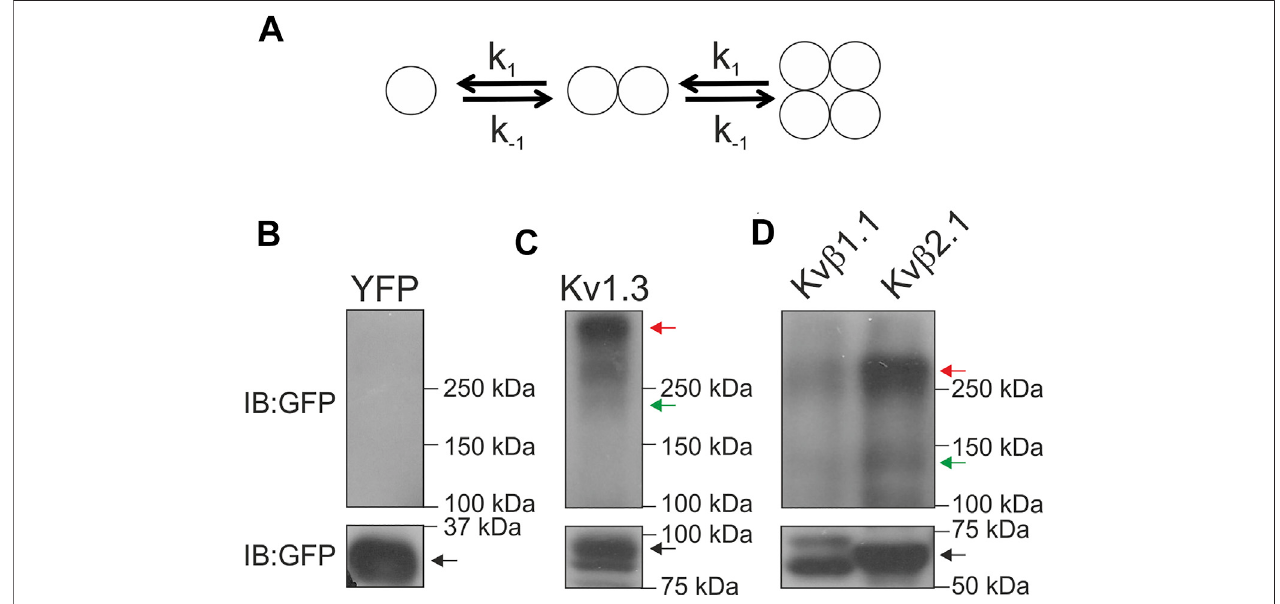
FIGURE5| Kv β 1.1andKv β 2.1formdimericand tetrameric structures. (A) Modelrepresentingthetwoputative optionsforKv β oligomerization.Kv β formsdimers, andKv β formstetramericstructuresbyassociation.Theaf fi nityconstant(k)foreverystepwouldbethesameinallconditions. (B – D) HEK293cellsweretransfectedwith YFP, Kv1.3YFP, Kv β 1.1YFP and Kv β 2.1YFP. Total lysates were analyzed in semidenaturating conditions. (B) YFP, (C) Kv1.3YFP, (D) Kv β 1.1YFP and Kv β 2.1YFP. Immunoblots (IB) were performed with an anti-GFP antibody. Blots were split into two for low- and high-molecular-weight forms for better visualization. The black arrow indicates monomeric forms. The green arrow indicates dimeric forms. The red arrow highlights tetrameric forms.